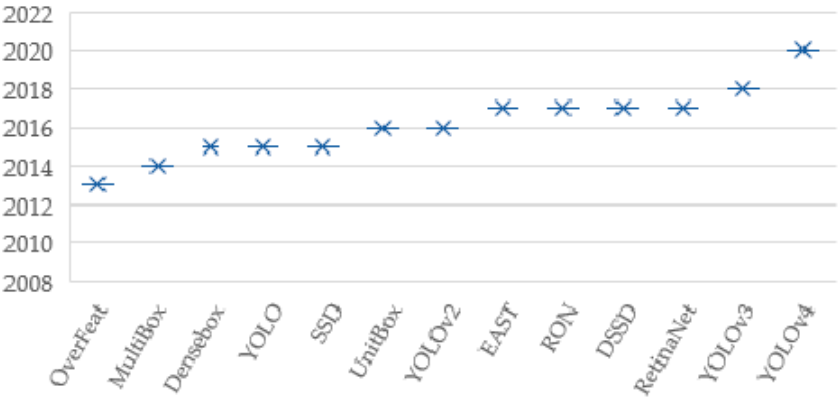
Figure 1. History of one-stage detectors.